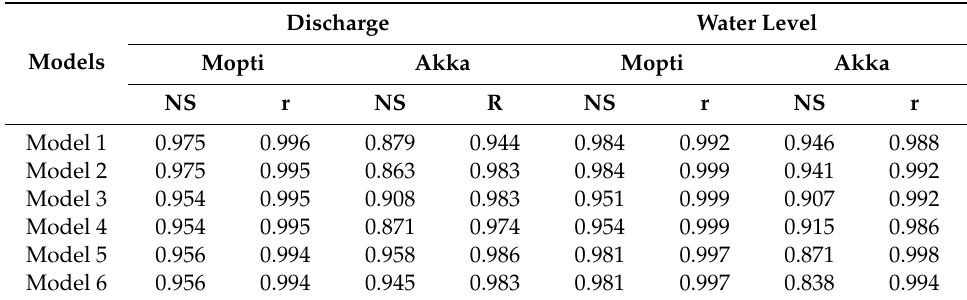
Table 6. Correlation (r) and Nash-Sutcli ff e (NS) coe ffi cients for simulated discharge and water level at the